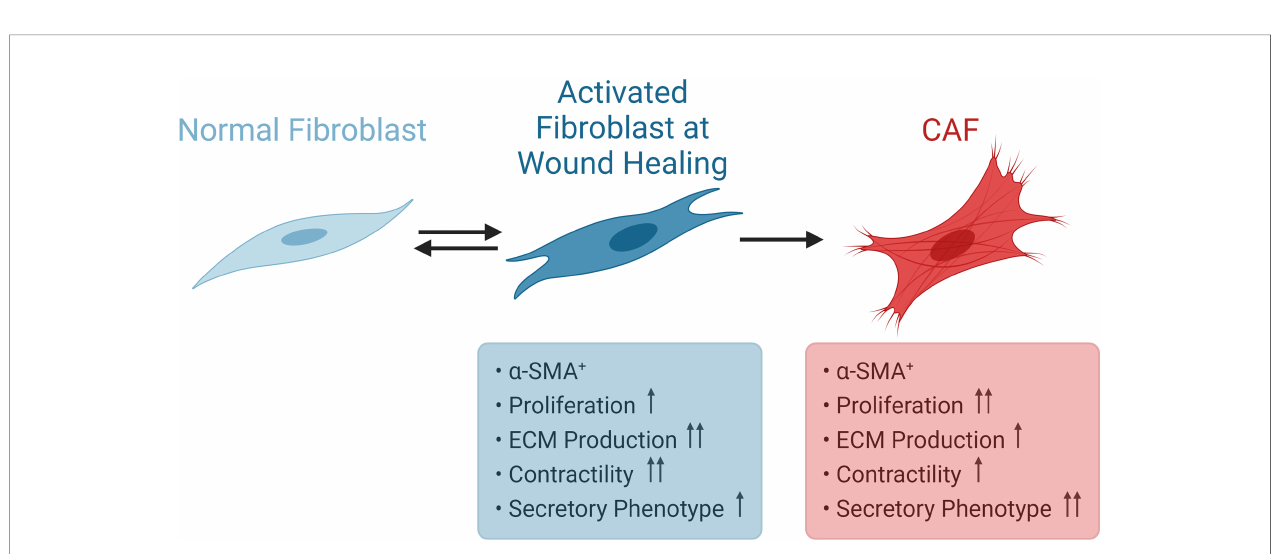
FIGURE 4 | Activation of Fibroblasts. Normal fi broblasts are spindle shaped cells. During wound healing, fi broblasts become reversibly activated and express a -SMA. CAFs also express a -SMA, but display higher proliferative capacity and secretory phenotype. CAF, cancer associated fi broblast; a -SMA, a -smooth muscle